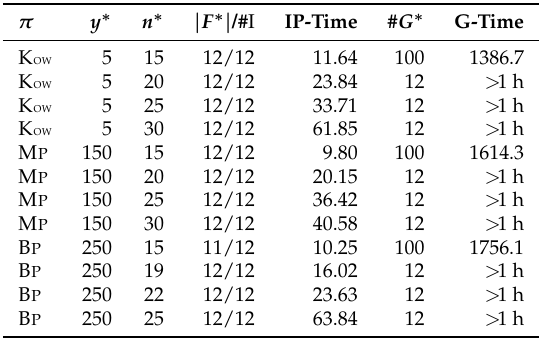
Table 7. Results of Steps 4 and 5 with d max = 3 and θ = 2.